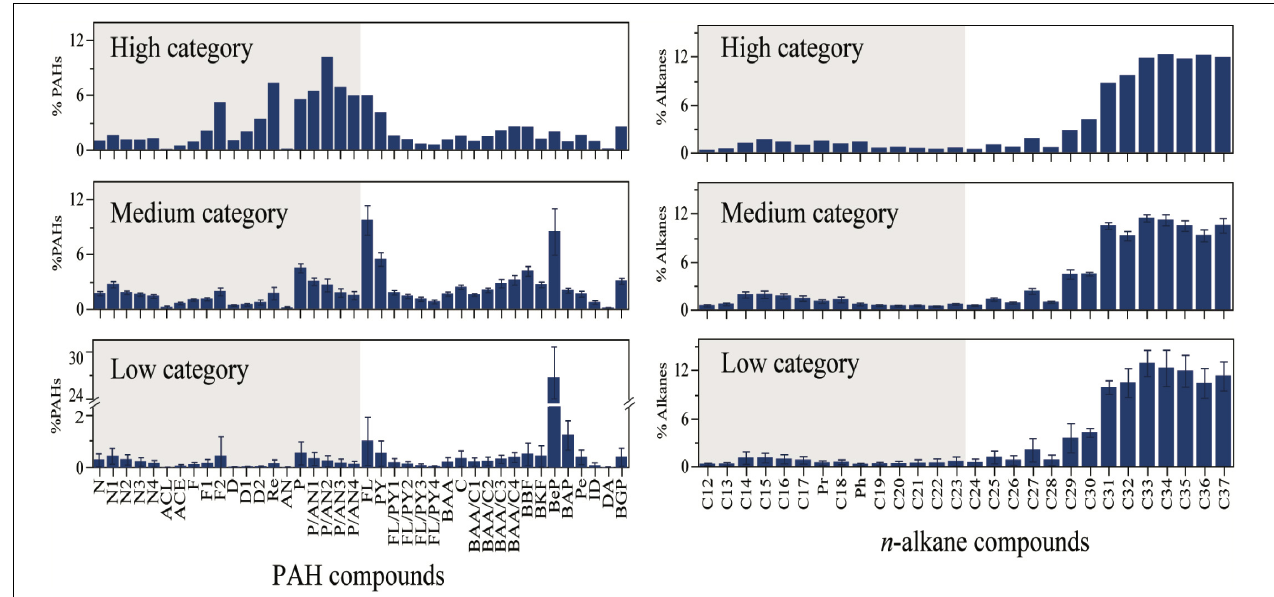
FIGURE 6 | Relative abundance of PAHs and n -alkanes by categories of %LMW compounds: high (PAHs: 62.3%; alkanes: 10.4%), medium (PAHs: 32.9 ± 3.1%; alkanes: 12.6 ± 2.2%), and low (PAHs: 7.8 ± 4.4%; alkanes: 7.9 ± 3.9%). Contaminated sediment samples were collected in 2018 in the nGoM (buried sediment layer deposited in 2010–2013). Data shown as mean ± 95% confidence interval.